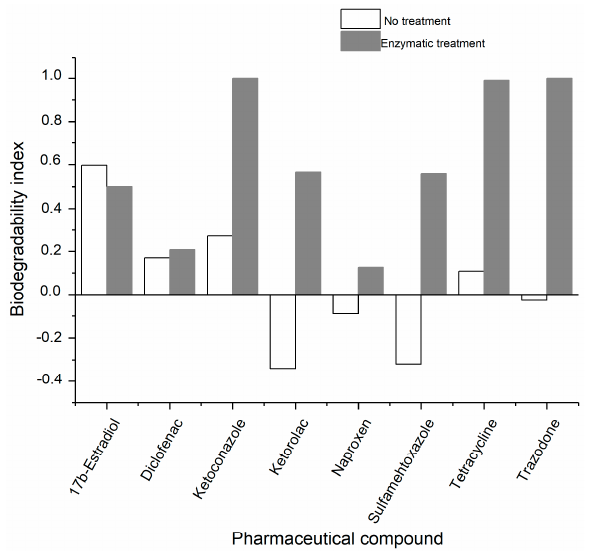
Figure 4. Biodegradability indexes of the PhCs and their CPO oxidation products.